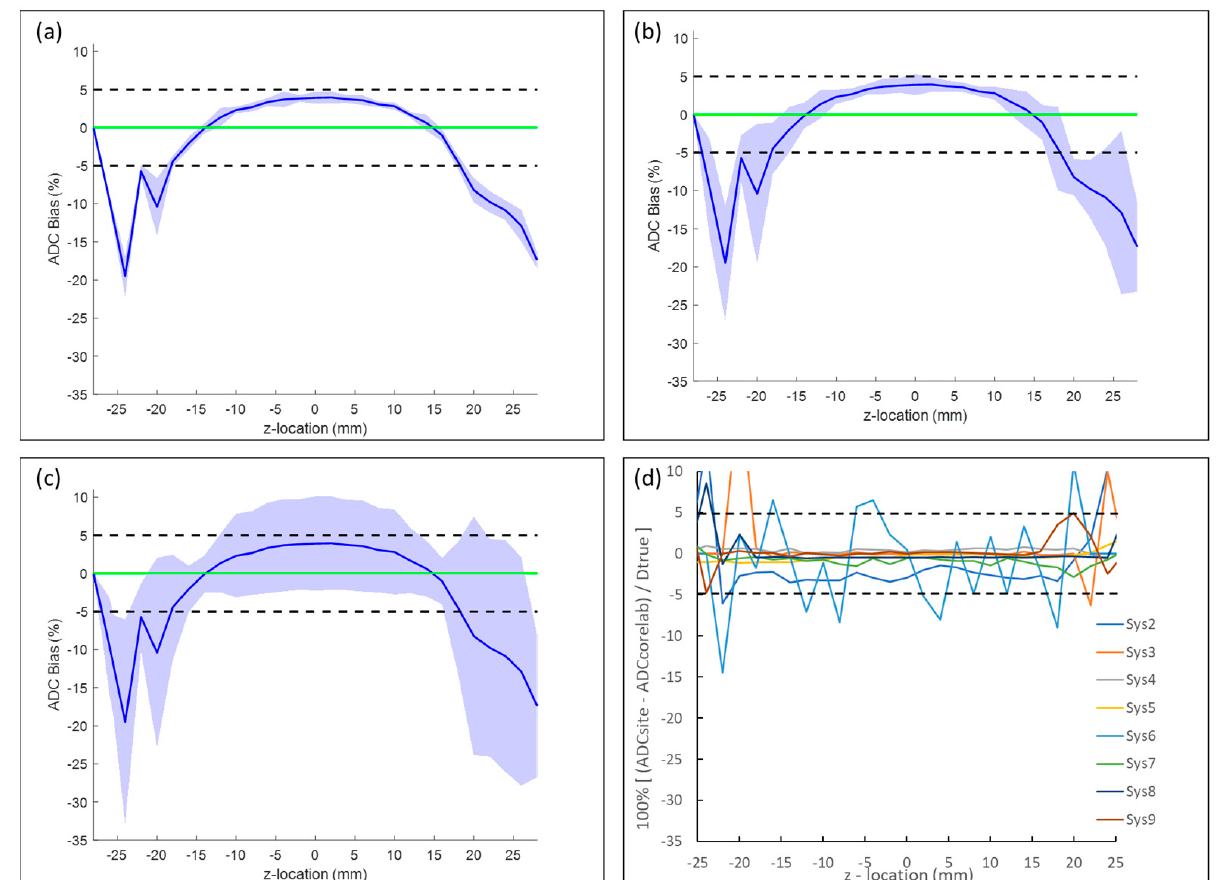
Figure 4. Summary of bias and repeatability for all studied systems: ( a ) mean bias (blue line) and short-term (intra-exam) repeatability relative to Dtrue, plotted as a function of z -axis location. Note, systems 8 and 9 did not provide short-term repeatability data (Table 1). ( b ) Corresponding plots for long-term (inter-exam) repeatability. Shaded regions in ( a ) and ( b ) represent bias ± 100% wSD /Dtrue. ( c ) Cross-system reproducibility, where shaded region represents bias ± 100% SD /Dtrue. Green line denotes ideal 0% bias. ( d ) Difference between site-generated and core-lab-generated ADC relative to Dtrue. Difference for core-lab systems 1 and 10 is zero (not plotted). Plots are on the same scale to aid visual comparison of bias, short- and long-term repeatability, reproducibility, and difference between site- versus core-lab ADC generation routines.